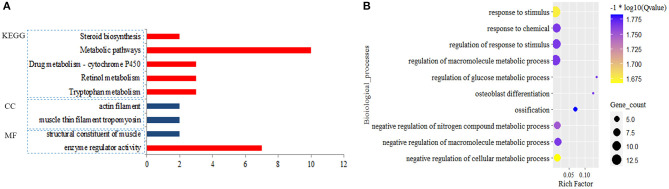
Significantly enriched function for the target genes of differential expression miRNAs (DEmiRNAs). Blue pillar represented the enrichment from down-regulated target genes and red pillar from up-regulated target genes by DEmiRNAs (A); Biological process (B).